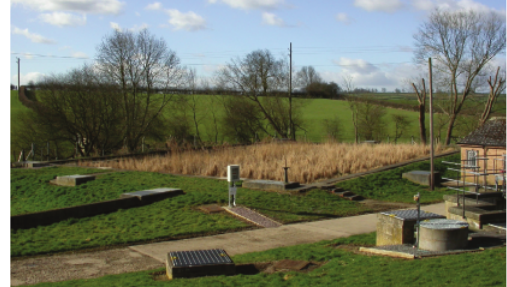
Figure 1: Tertiary treatment reed-bed at Thorpe Satchville Waste- water Treatment Works, Leicestershire Thorpe Satchville, an ex- ample of a tertiary treatment reed-bed for